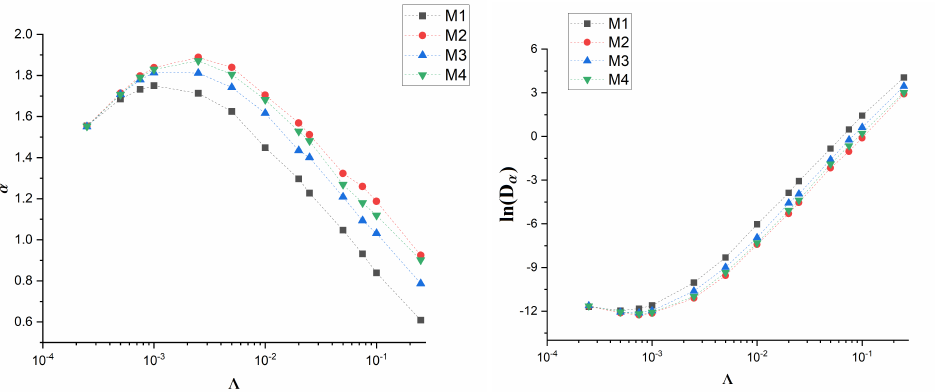
Figure 8. Dependence of α ( left ) and ln D α ( right ) on drift for artificial membranes